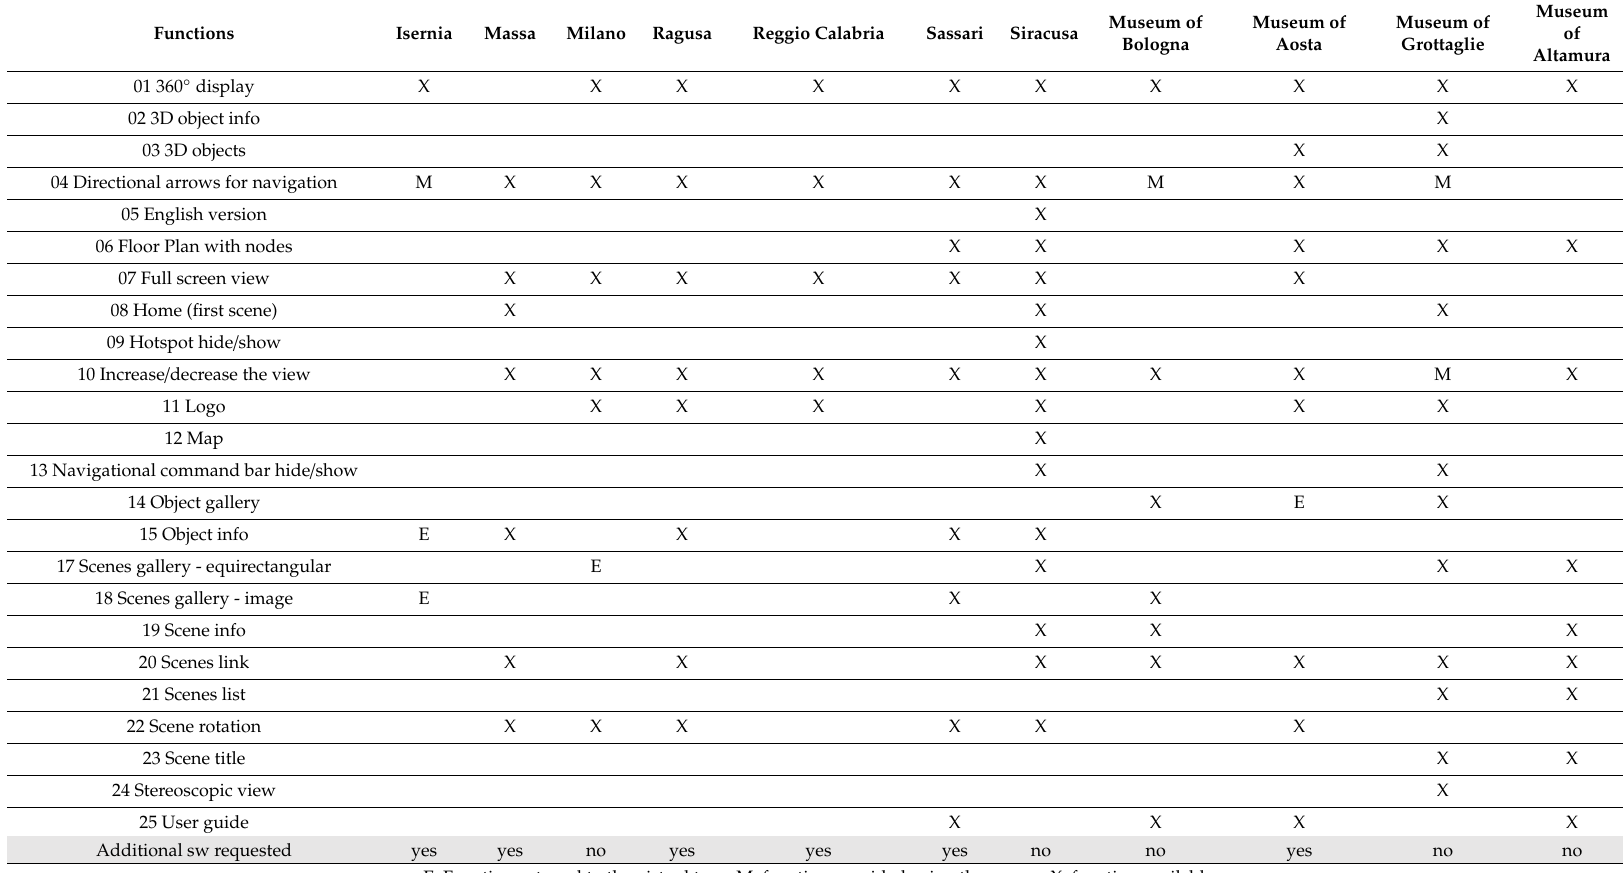
Table 2. Functions in virtual tour interfaces in county towns and in a selection of